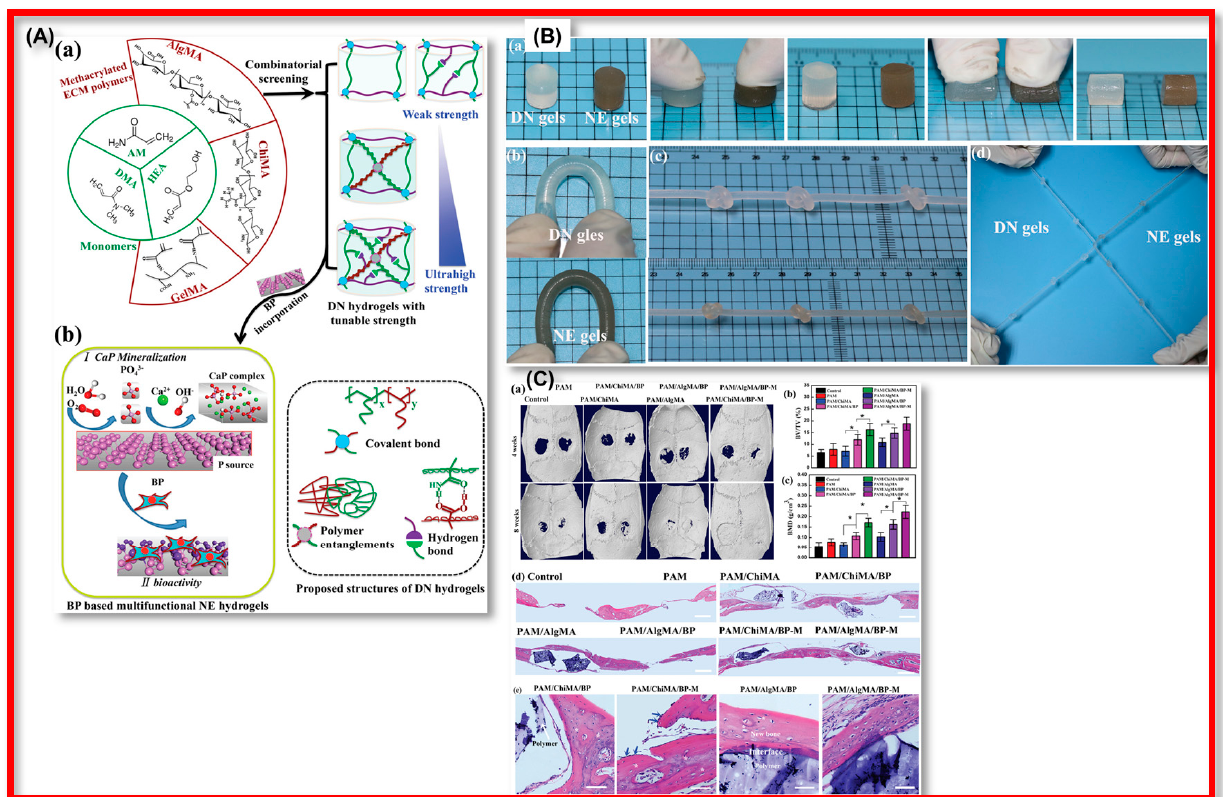
Figure 23. ( A ) (a) Schematic illustration of combinatorial screening of double network (DN) hydrogels with tunable strength and subsequently construction of bioactive nanoengineered (NE) hydro- gels composed of black phosphorus (BP) nanosheets. The combinatorial screening DN hydrogels were prepared using one of three established biocompatible synthetic macromolecules to form the first ductile network (poly(2-hydroxyethylacrylate) (PHEA), poly(N,N-dimethyl acrylamide) (PDMA), or polyacrylamide (PAM) and one of three methacrylate-decorated natural polymers orig- inated from ECM molecules as the second brittle network chitosan methacrylate (ChiMA), alginate methacrylate (AlgMA), or gelatin methacrylate (GelMA). (b) As a result, the networks composed of